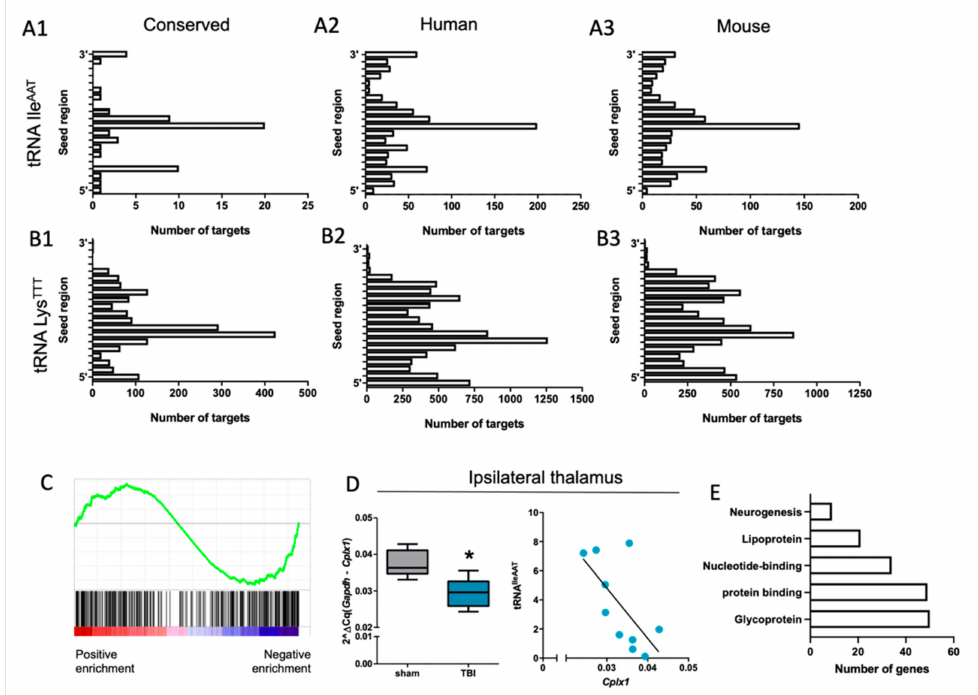
Figure 9. Downregulation of the predicted targets of upregulated tRFs after traumatic brain in- jury. ( A1–A3 ) Number of predicted targets of 3 (cid:48) tRF-IleAAT for conserved, human and mouse 3 (cid:48) -untranslated regions (UTRs) of protein coding genes. ( B1–B3 ) Number of predicted targets of 3 (cid:48) tRF-LysTTT for conserved, human, and mouse 3 (cid:48) -UTRs of protein-coding genes. ( C ) Gene set enrichment analysis of predicted targets of both tRFs (combined gene list) in the ipsilateral thalamus revealed negative enrichment (ES = 0.22, FDR <0.01). ( D ) Quantitative RT-PCR analysis validated downregulation of one selected target candidate of 3 (cid:48) tRF-IleAAT, Cplx1 (FC = 0.78, p < 0.05). Further, the lower the Cplx1 expression level, the greater the detection of 3 (cid:48) tRF-IleAAT in the same sample (Spearman r = 0.43, p < 0.05). ( E ) Functional annotation of negatively enriched predicted tRF targets linked them to glycoprotein, protein binding, nucleotide-binding, lipoprotein, and neurogenesis ( p < 0.05, DAVID functional annotation tool). Statistical significance: *, p <